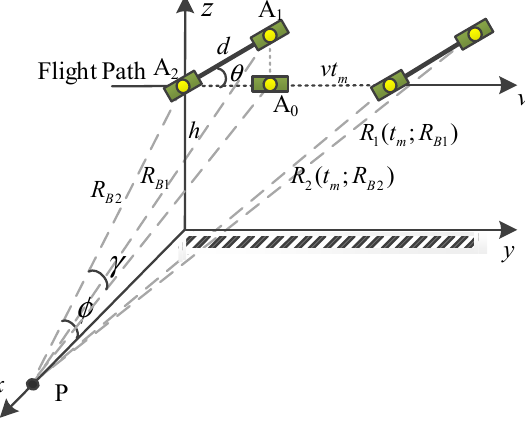
Figure 1. The imaging geometry for an airborne dual-channel CSAR/GMTI system.